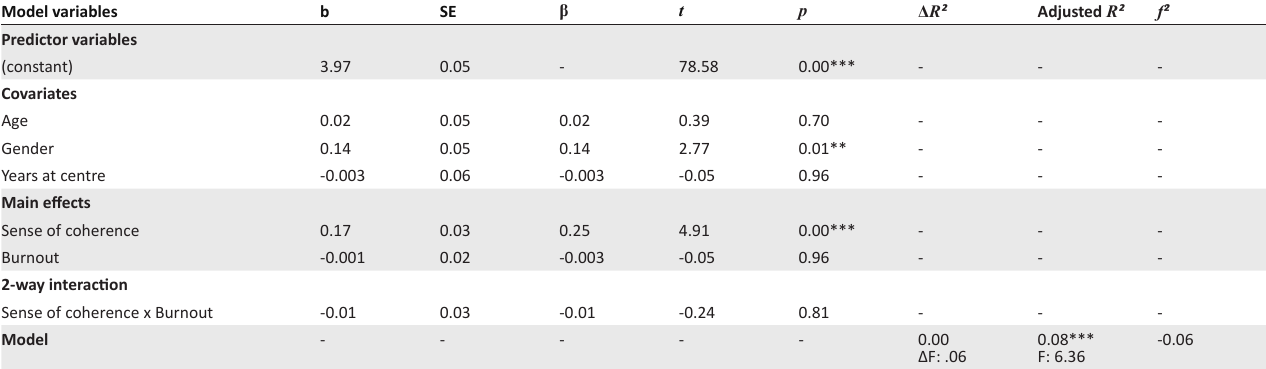
TABLE 3: Results of the moderated-regression analysis examining the interaction effects of sense of coherence (OLQ) and burnout (MBI) in predicting career adaptability (CAAS) ( N = 409). Model